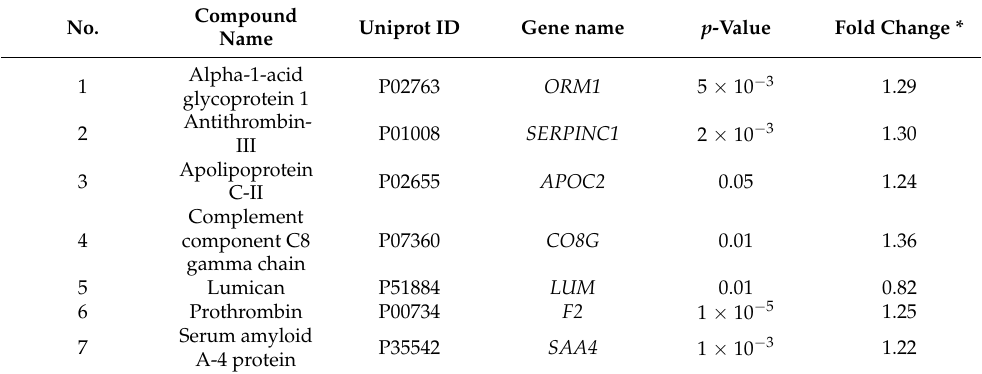
Table 2. Candidate proteins with associated p -value and fold-change.